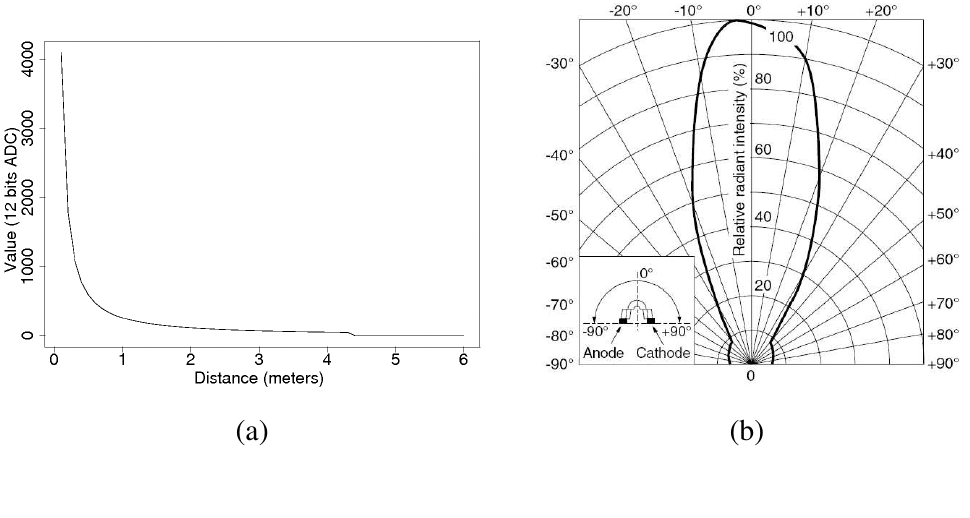
Figure 12. Reception values for different distance and angle